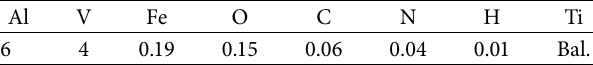
Figure 1: Four stages in linear friction welding [28]. Table 1: Elemental composition of Ti6Al4V alloy